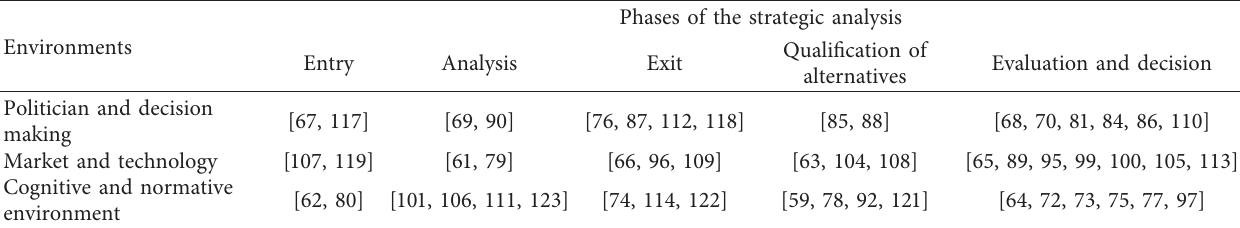
Table 6: Classification of investigations - strategic creation and organizational structures